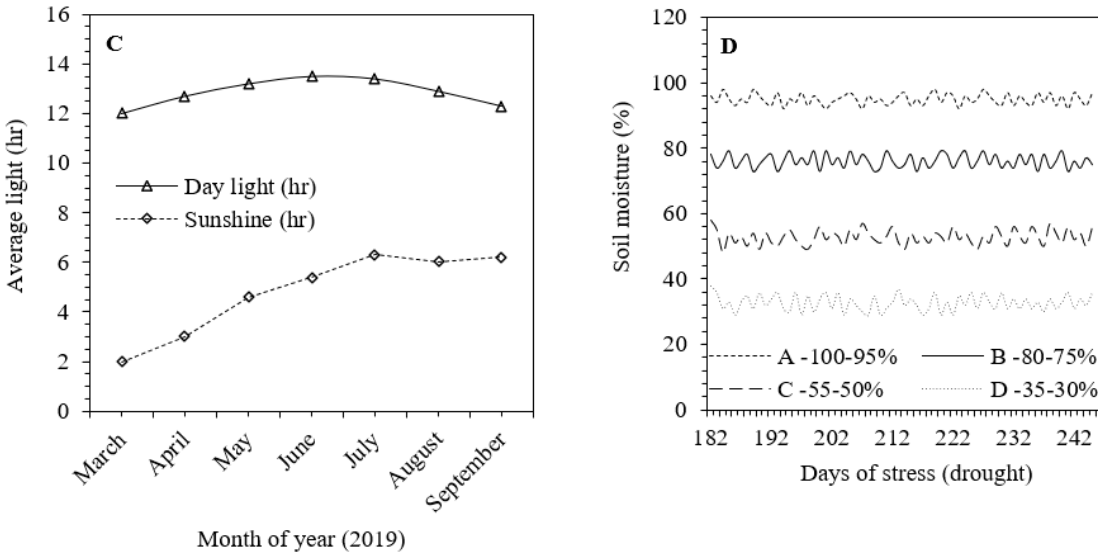
Figure 1. ( A ) Diurnal variation in average temperature (°C), ( B ) air relative humidity (%), ( C ) day light–sunshine (h) and ( D ) soil moisture (%) during the